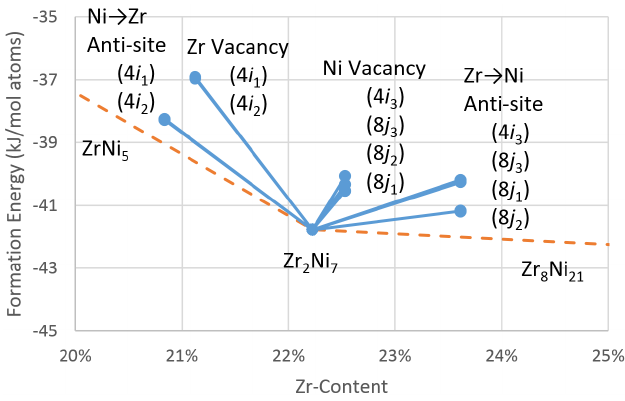
Figure 4. Formation energies for Zr 2 Ni 7 and its point defects with tie lines.